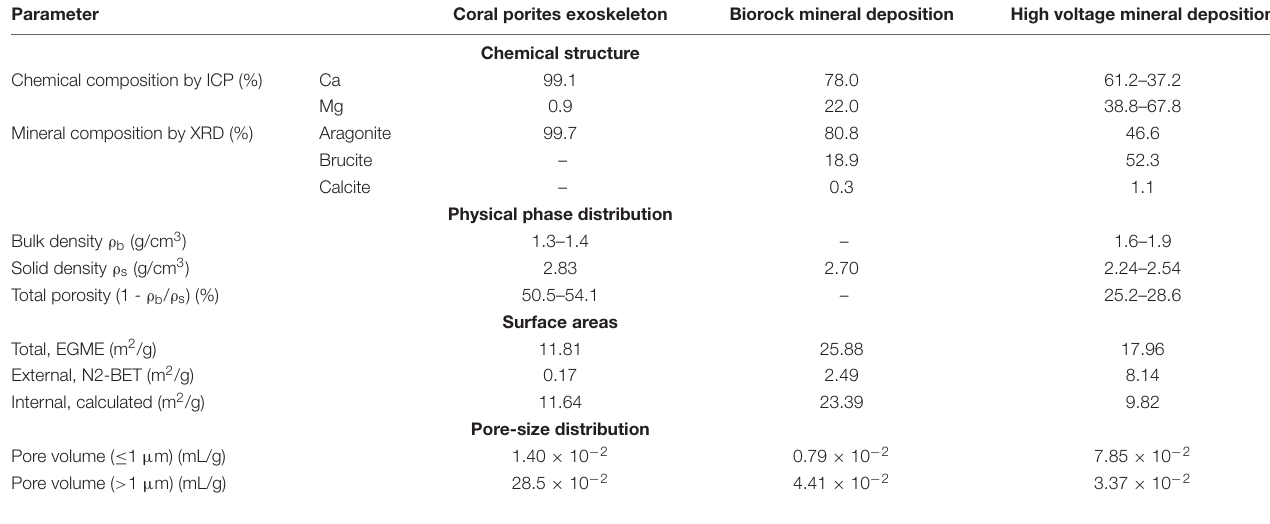
TABLE 2 | Physical-chemical properties of CPE, LVMD, and